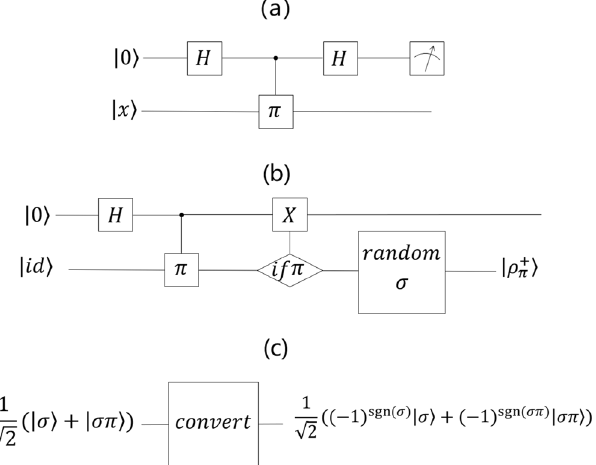
Figure 3. ( a ) The quantum circuit of the distinguishing algorithm, where H represents the Hadamard 1 1 0 0 1 1 0 1 ) ) ( ( operations H and H and π represents the π operation √ 2 √ 2 | | | | � = � + | � = |+� � = � − | � = |−� π σ σπ . We perform the quantum circuit from left to right. ( b ) The quantum circuit of the ρ + π ( n ) | � = | � π generation algorithm, where “if π ” means “if we read from this register” and “random σ ” means “perform a | � random permutation σ on this register”. ( c ) The quantum circuit of the conversion algorithm, where we perform 1 1 1 ) sgn (σ) 1 ) sgn (σπ) σ σπ σ σπ ) ( ( ( the following “convert” operation: convert √ 2 √ 2 | | | [ � + | � ] = − � + − � (cid:31) (cid:30)